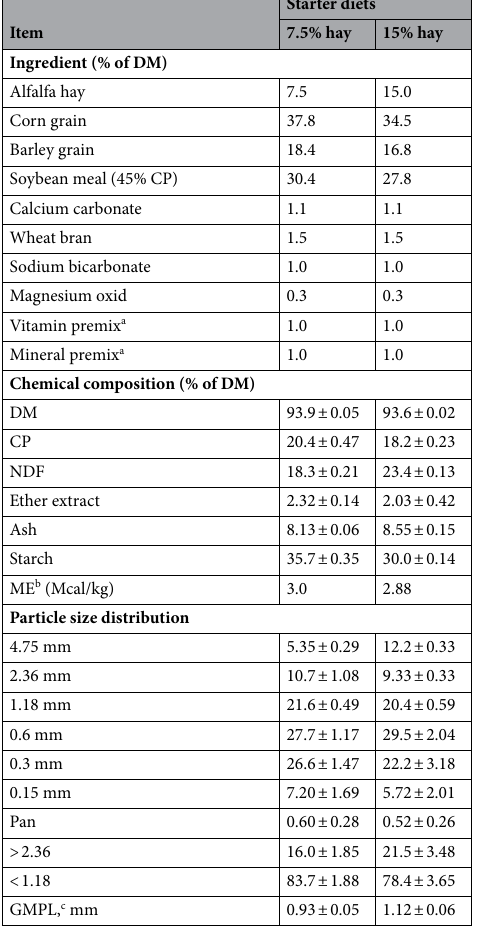
Table 1. Ingredients, chemical compositions, and particle size distribution of the experimental diets. a Contained per kilogram of supplement, 250,000 IU vitamin A, 50,000 IU vitamin D, 1500 IU vitamin E, 2.25